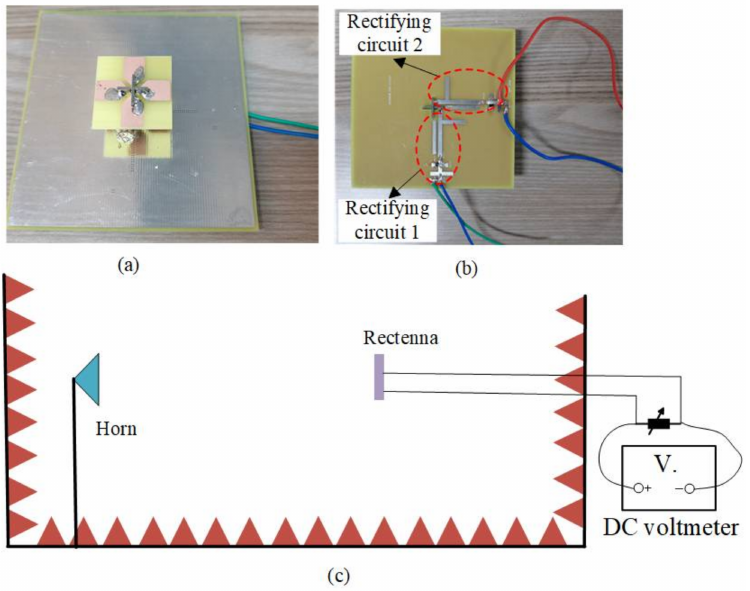
Figure 13. Photos of the proposed rectenna and the test setup. ( a ) Top view of the rectenna. ( b ) Back view of the rectenna. ( c ) Test